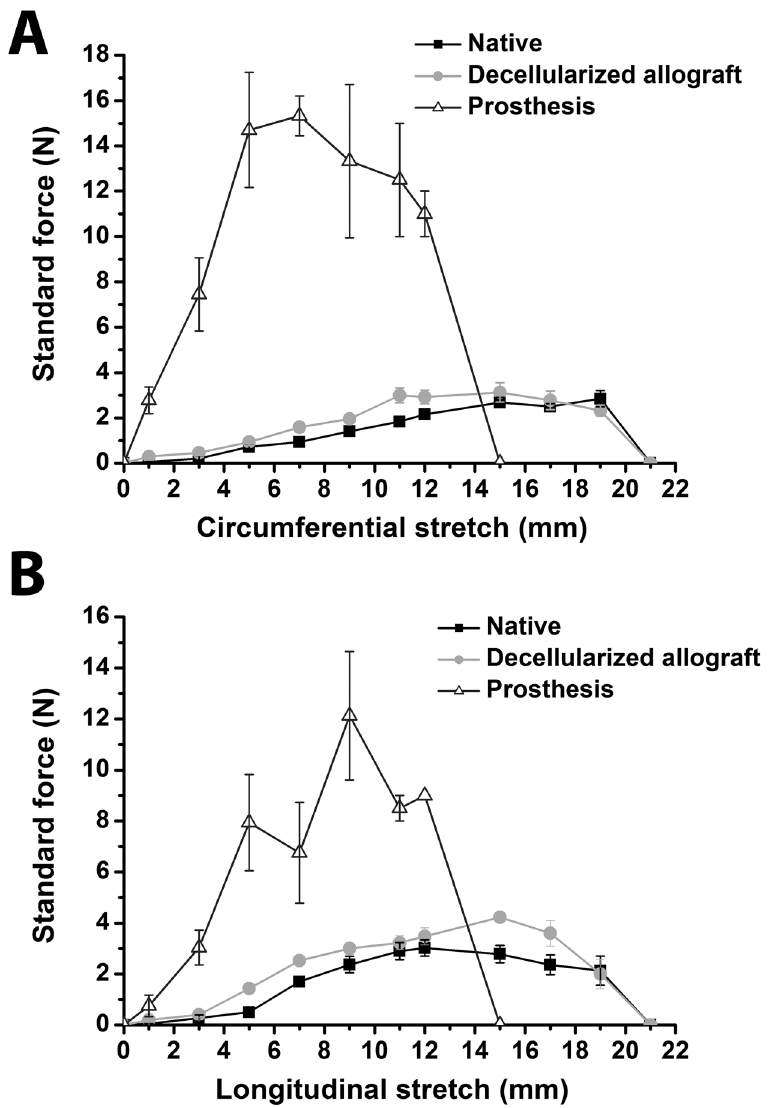
Figure 4. In vitro biomechanical properties. Circumferential (A) and longitudinal (B) stress-strain curves of prostheses, native and decellularized aortic arches. All data are expressed as means 6 SEM.